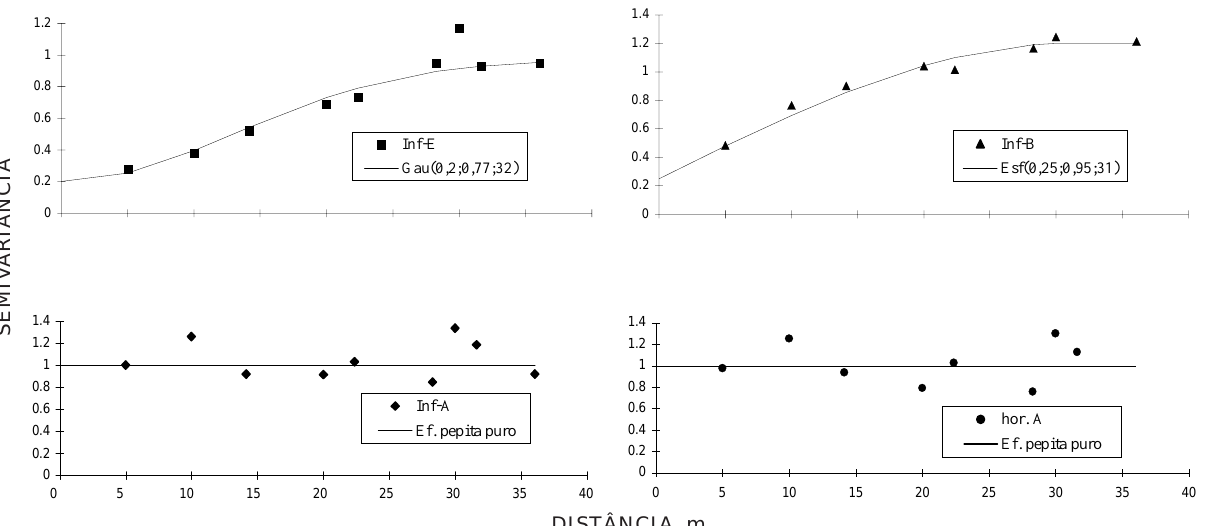
Figura 3. Semivariogramas escalonados da infiltração de água no horizonte A, E e Bt e da espessura do horizonte A, sob